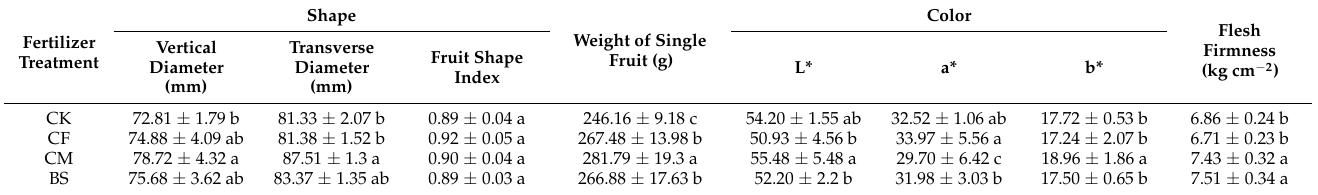
Table 2. Physical properties of apple fruit response to different fertilizers application. Shape